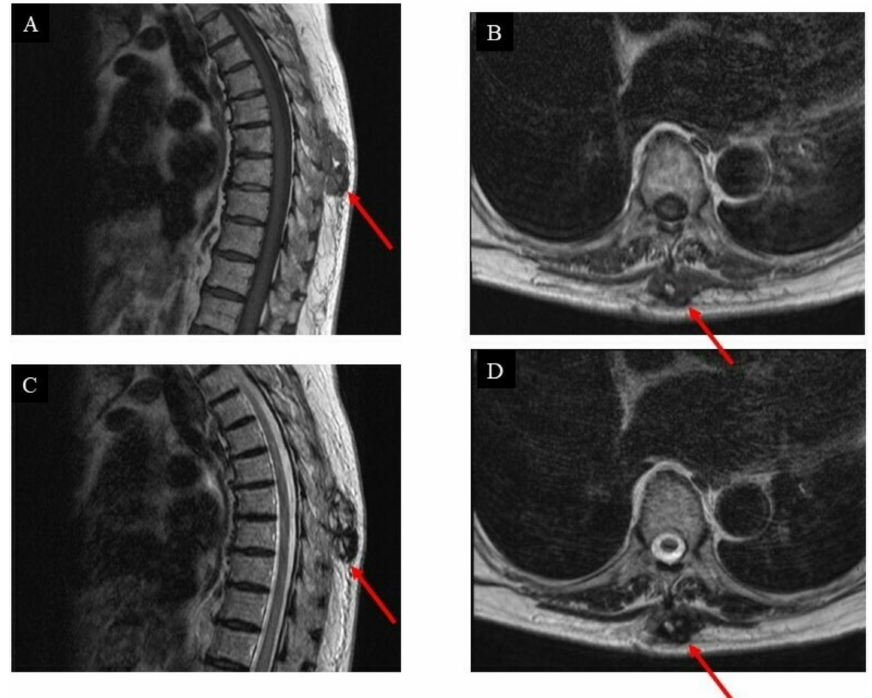
Figure 2. Images of the intrinsic back musculature of a 78-year-old female patient before treatment: ( A ) sagittal magnetic resonance imaging (MRI) T1-weighted sequence; ( B ) axial MRI T1-weighted sequence; ( C ) sagittal MRI T2-weighted sequence; ( D ) axial MRI T2-weighted